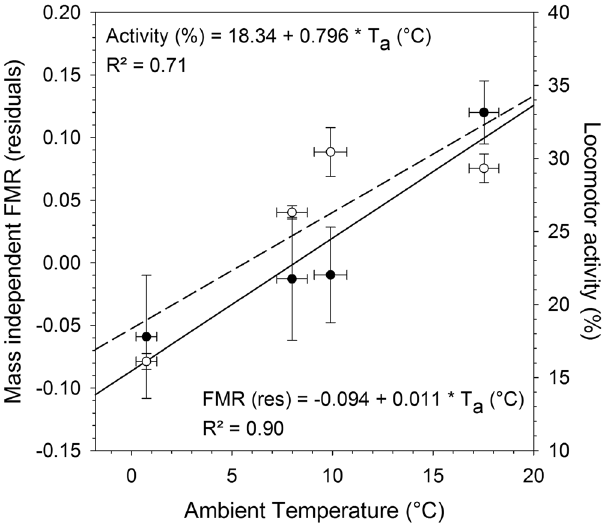
Figure 4. Field metabolic rate (FMR) and locomotor activity in llamas. Date are average FMR ( • ) and activity ( ○ ) values of llama dams (N = 7) with the corresponding fit lines (FMR: solid line; Activity: dashed line) measured at four different seasons, i.e. ambient temperature ranges. FMR values are given as residuals from the regression of FMR on body mass.